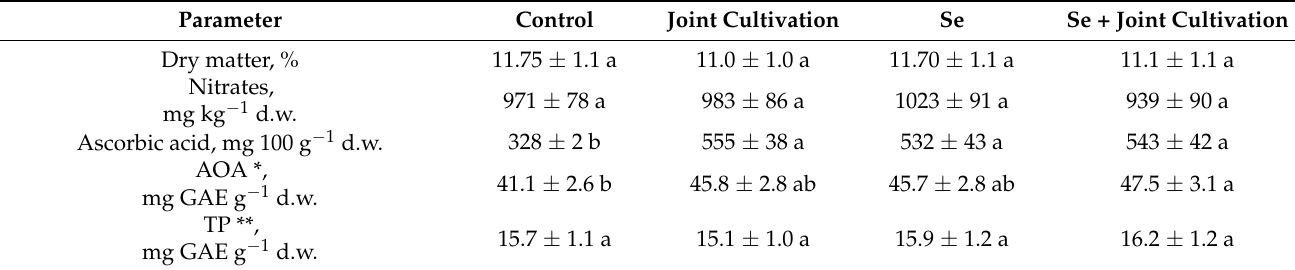
Table 3. Biochemical characteristics of ramson ( Allium ursinum )